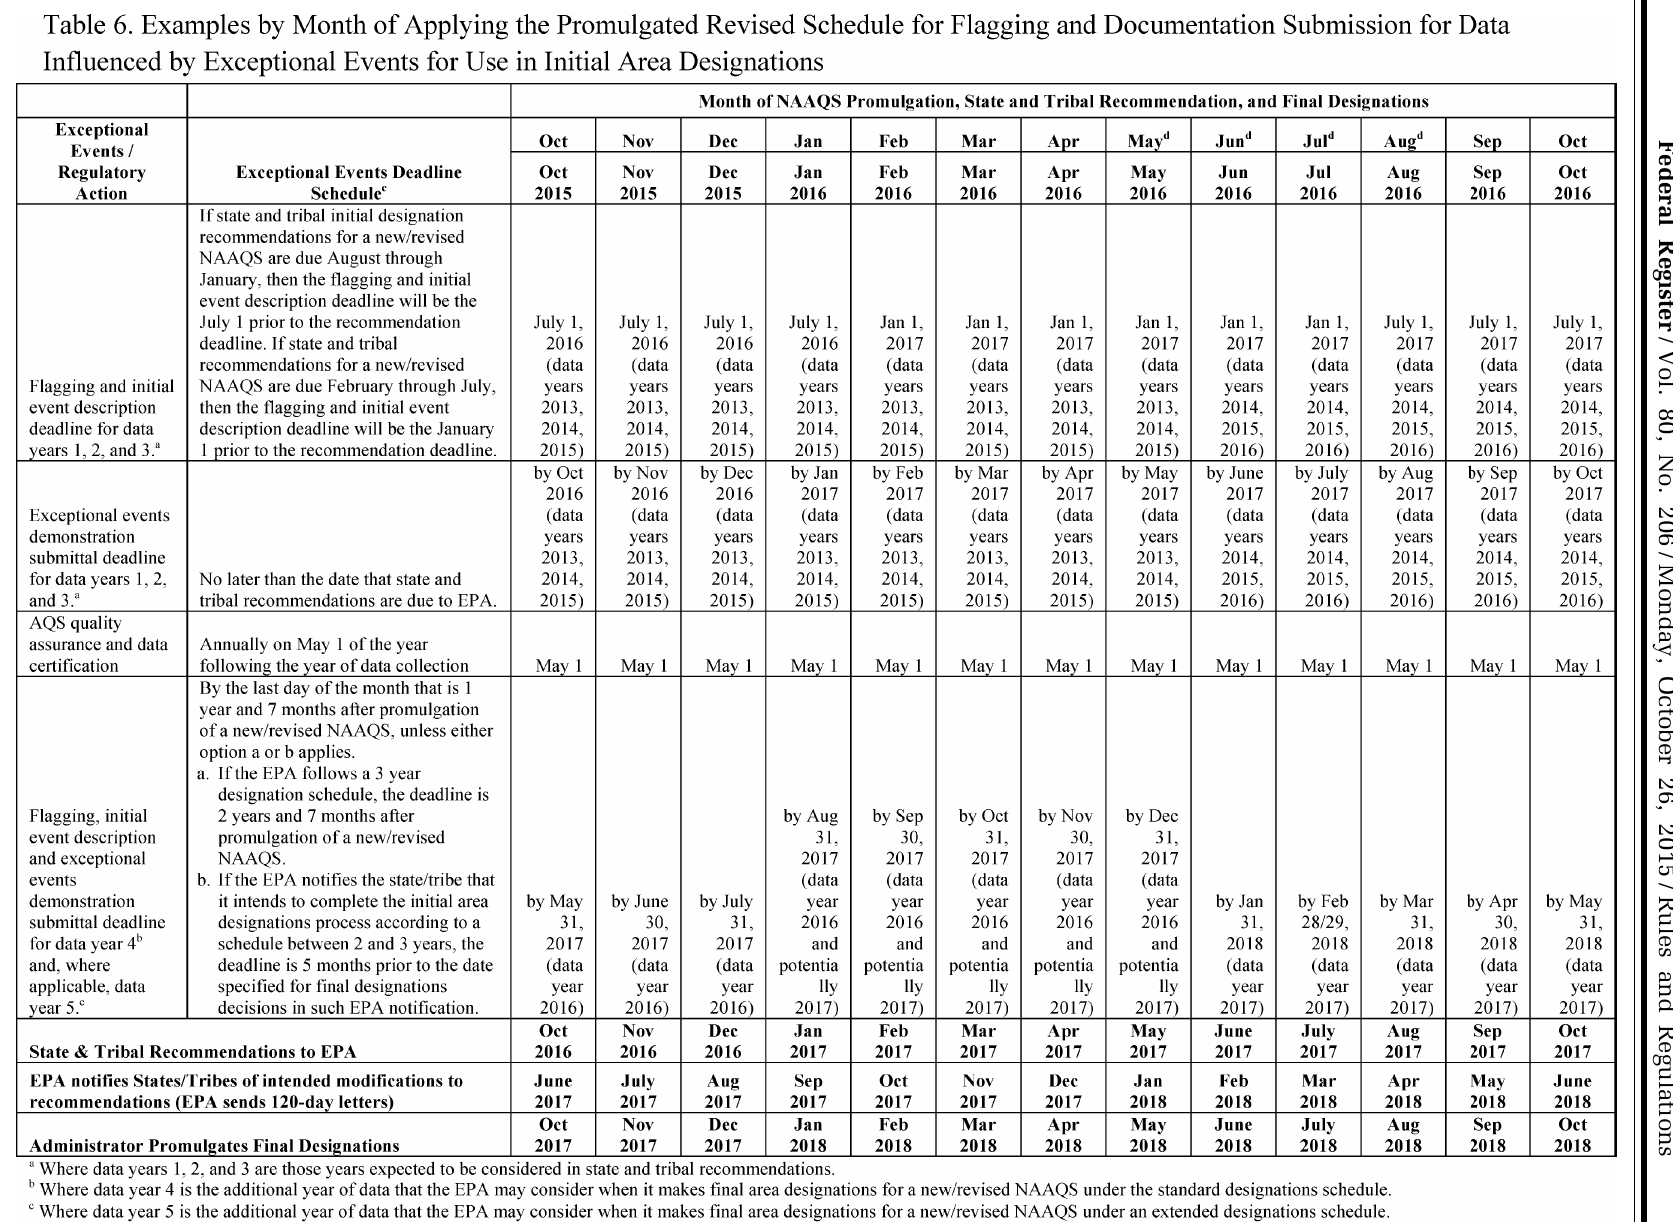
Table 6. Examples by Month of Applying the Promulgated Revised Schedule for Flagging and Documentation Submission for Data Influenced by Exceptional Events for Use in Initial Area Designations